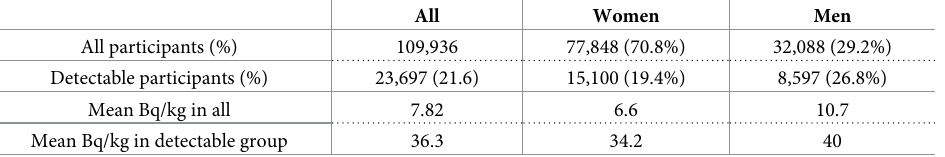
Table 4. Population, participants with detectable contamination, and mean 137 Cs concentration (Bq/kg) by sex.